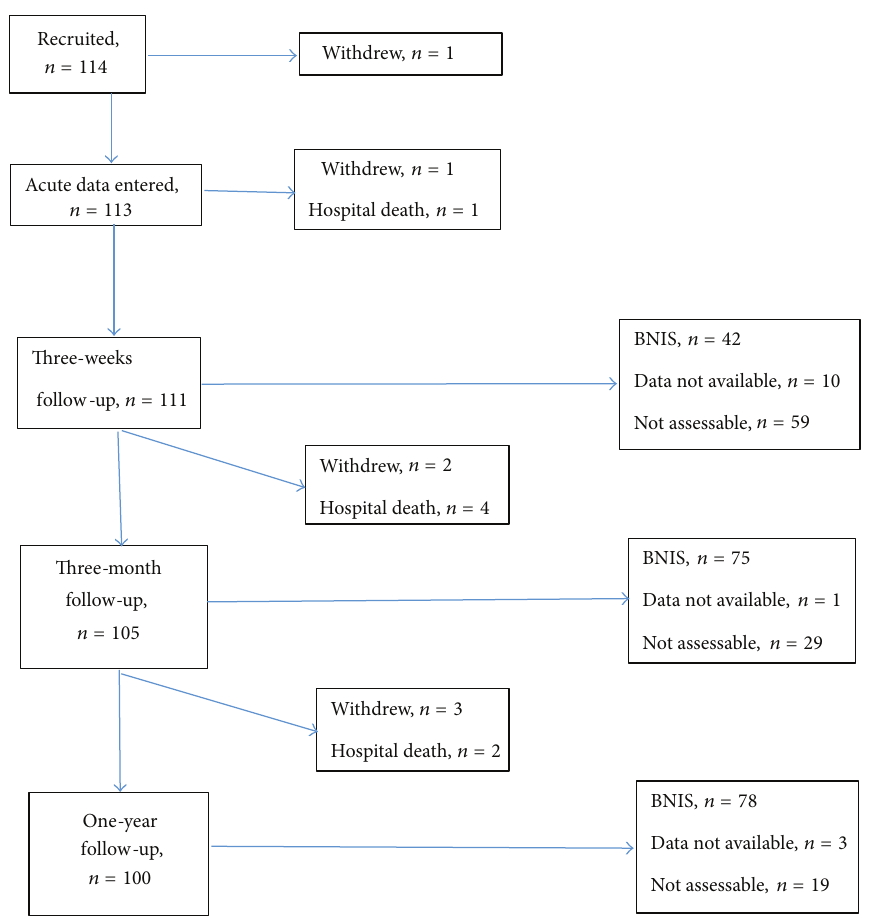
Figure 1: Flow chart of patients through the